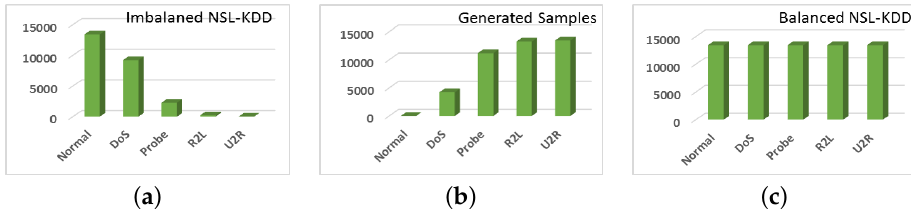
Figure 5. NSL-KDD dataset. ( a ) Imbalanced original records; ( b ) Generated records; ( c ) Balanced